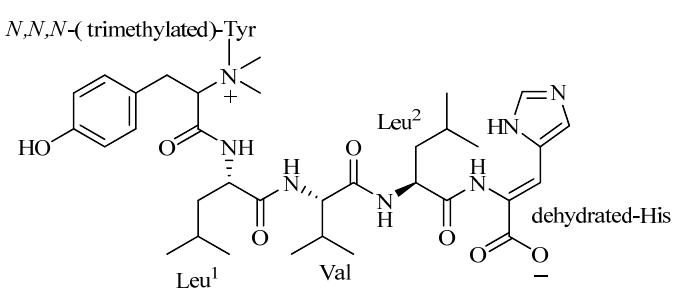
Figure 1. The structure of